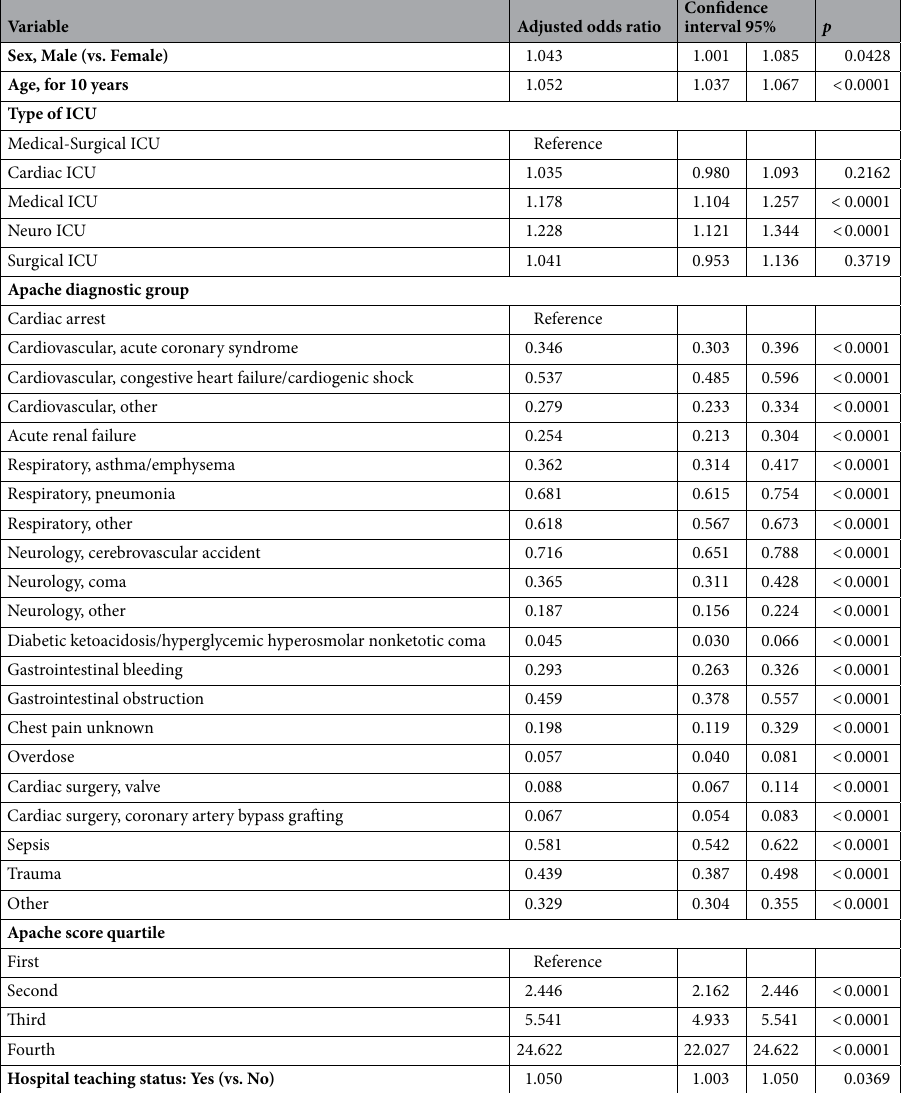
evaluation; ICU, intensive care